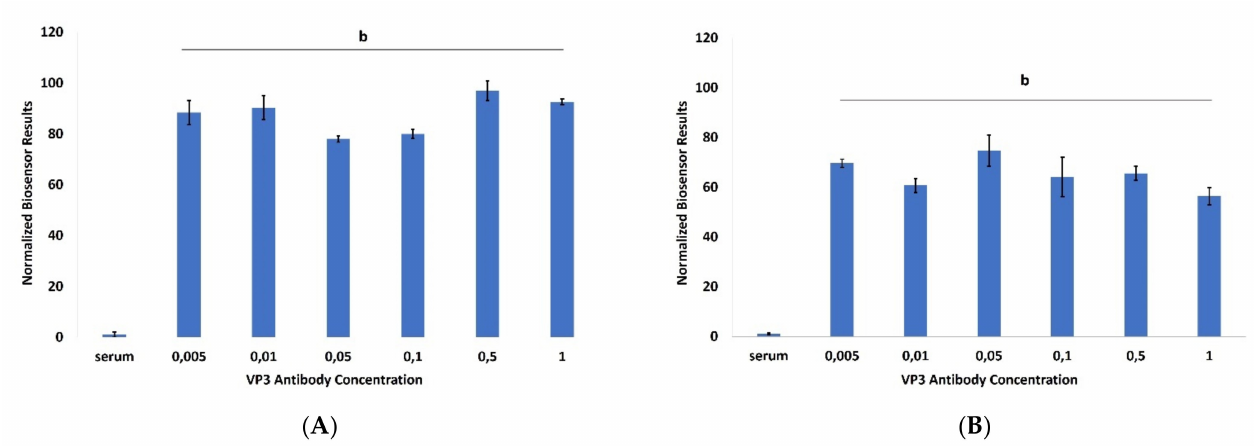
Figure 4. Normalized biosensor responses against 6 different concentrations of the rhinovirus VP3 antibody (0.005, 0.01, 0.05, 0.1, 0.5, 1 µ g/mL) in human blood serum. Responses of membrane- engineered SK-N-SH cells with ( A ) 0.5 µ g/mL S1 protein. ( B ) 5 µ g/mL S1 protein. Results are presented as normalized biosensor responses (n = 24). b: statistically significant different results ( p <